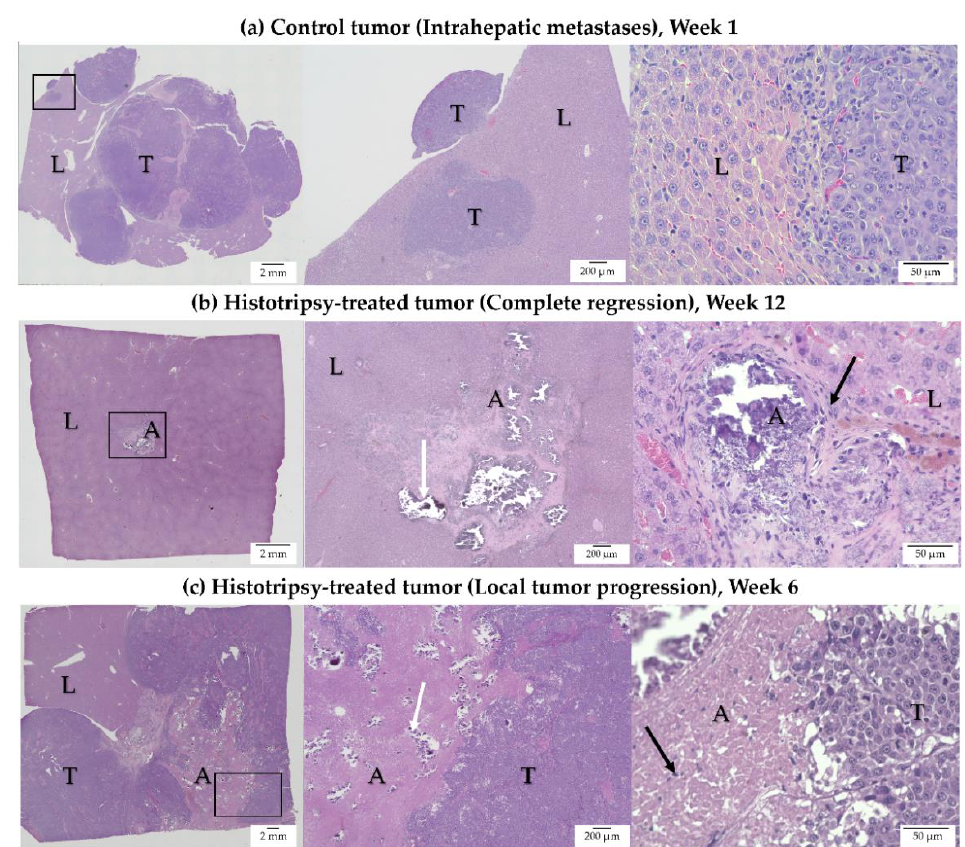
Figure 4. H&E-stained representative images for ( a ) untreated control, ( b ) histotripsy-treated tumor showing complete regression, and ( c ) histotripsy-treated tumor with local tumor progression (L: Liver, A: Ablation Zone, T: Tumor). For each row, the first panel shows a low-magnification view of the entire tissue section, with an identified region of interest (ROI), the second and third panel show the ROI at higher magnifications. ( a ) Control tumor — Week 1: Intra-hepatic tumor progression and metastases are observed in the untreated control. Tumor growth occupied most of the liver lobe.